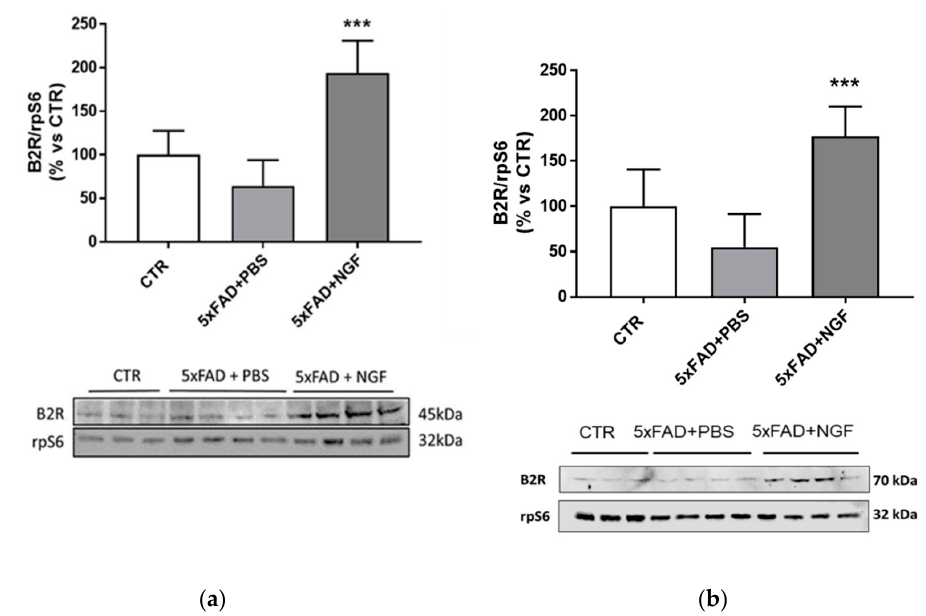
Figure 7. Overexpression of B2R by NGF treatment in 5xFAD brain extracts. Western blot analysis of B2R protein expression (panel ( a ) bands at 45 kDa; panel ( b ) bands at 70kDa) in brain extracts from wild type mice (CTR) and 5xFAD mice intranasally treated with PBS or NGF normalized against rpS6 and expressed as a percentage of the control (CTR). Data represent means ( ± S.E.M.) from four independent samples. Statistically significant di ff erences were calculated by one-way analysis of variance (ANOVA) followed by Bonferroni’s test for multiple comparisons. (*** p <